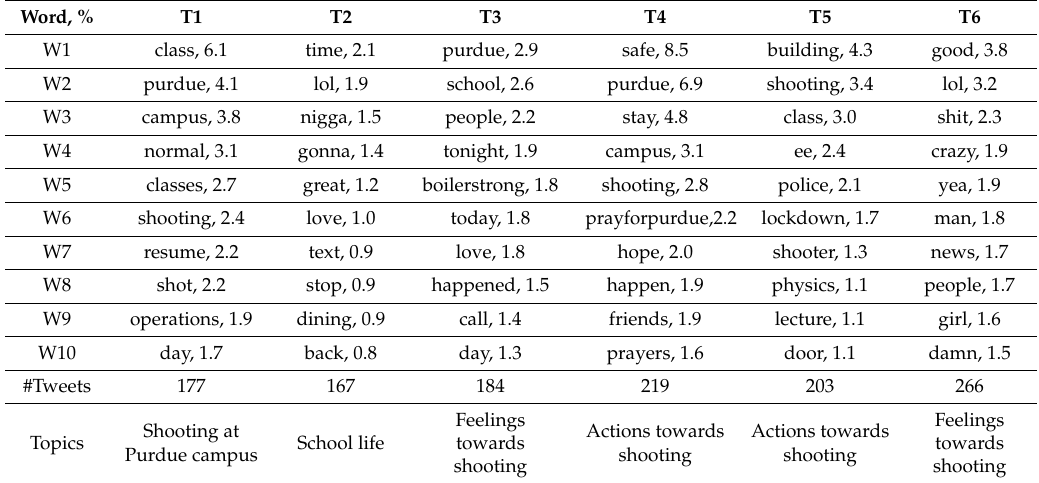
Table 2. Modeled topics of the most significant cluster about the gunshot in West Lafayette,